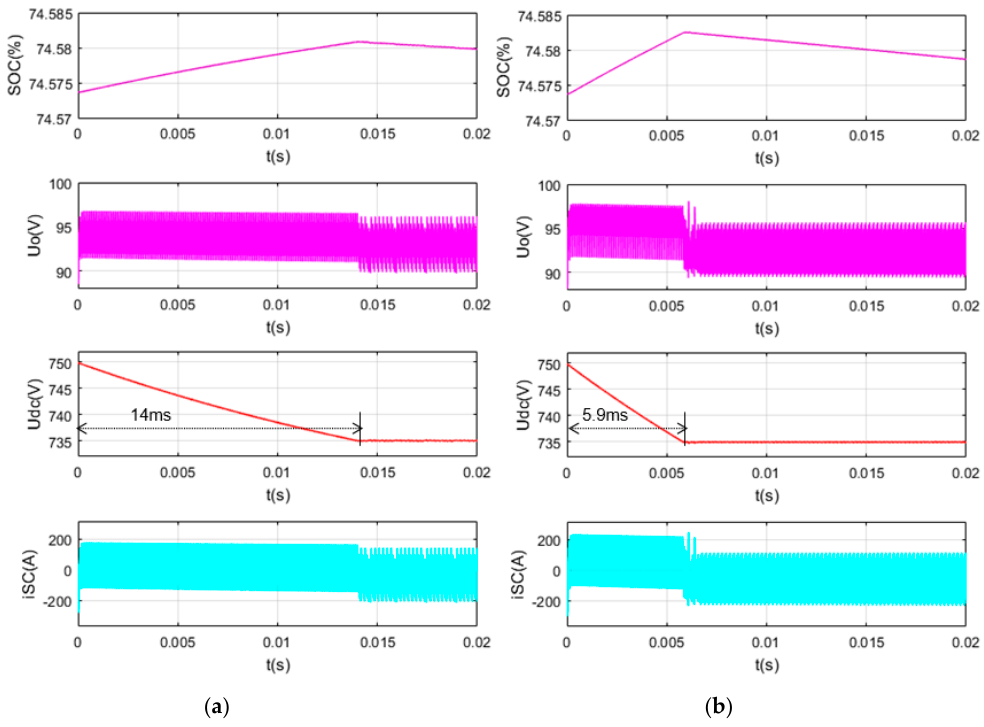
Figure 10. Simulation waveform diagram when the initial voltage, U dc , is 749.7 V and the initial voltage, U o , is 93.6 V: ( a ) MPC only for the DAB; ( b ) MPC for the DAB-SC system.